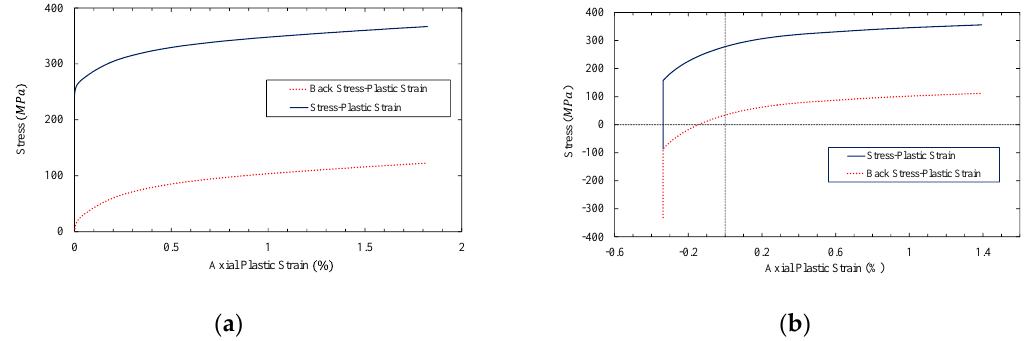
Figure 12. Stress-plastic strain and Backstress for elastic limit = 167.2 MPa obtained from ( a ) post-stabilized monotonic curve, ( b ) hysteresis curve. Figure 13. Stress-plastic strain and Backstress for elastic limit = 244 MPa obtained from ( a ) post-stabilized monotonic curve ( b ) hysteresis curve.